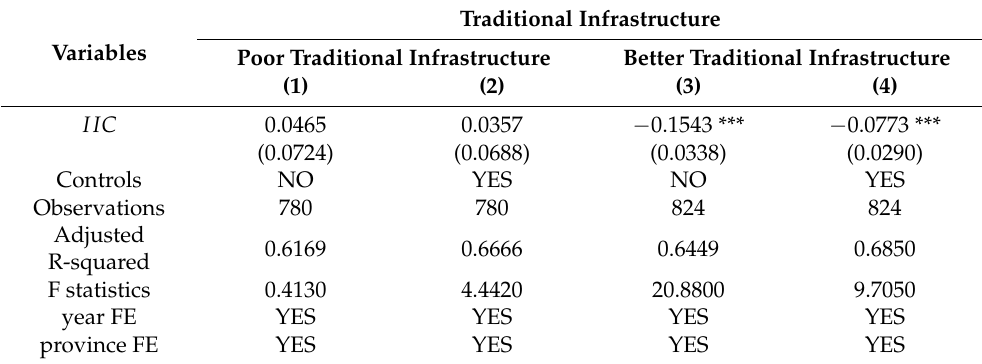
Table 5. Heterogeneity analysis: traditional